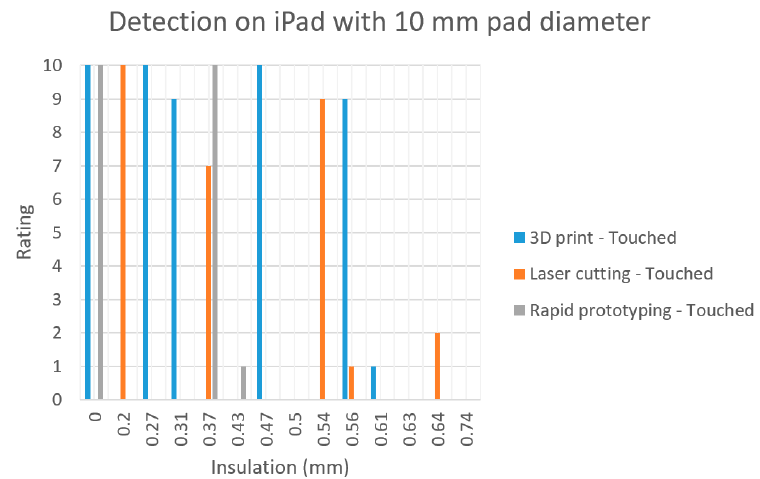
Figure 12. Detection performance (“Rating”) of different marker types with varying insulation layer using the large markers on the iPad.